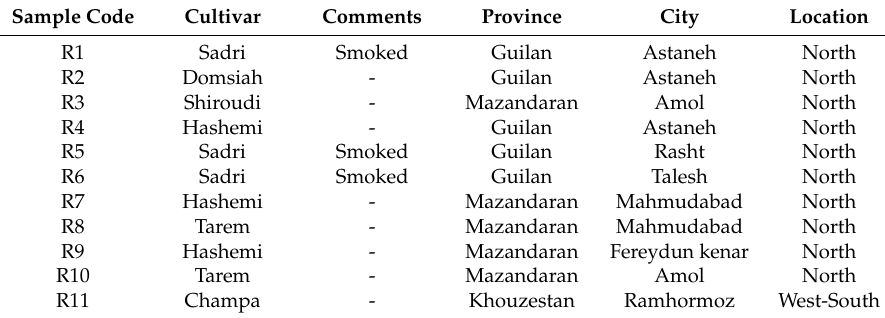
Table 1. Specifications of the samples of Iranian